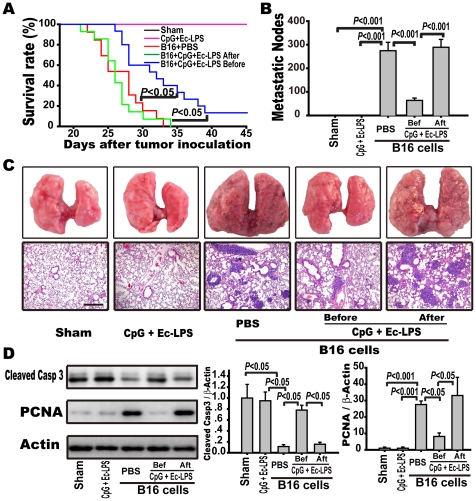
Prophylactic, but not therapeutic, administration of the complex attenuates pulmonary metastasis of B16 melanoma cells.C57BL/6 mice were injected i.v. with B16-F10 melanoma cells (5×105/mouse) and administered with the TLR4 agonist EC-LPS (12.5 µg/kg) plus the TLR9 agonist CpG ODN (0.25 mg/kg) i.p. every 3rd day for 3 doses before (prophylactic group) or after (therapeutic group) tumor cell inoculation. Control animals were treated with PBS or EC-LPS plus CpG ODN with an identical dosage and frequency as indicated in prophylactic group. The mice were humanely sacrificed, and their lungs were excised 14 days after tumor cell inoculation. Externally visible melanoma nodules on the lung surface were counted using stereo microscopy. (A) Kaplan-Meier graph representing the cumulative survival of mice in the indicated treatment groups. The data were analyzed using Kaplan-Meier survival analysis (n = 15 per group). (B) The metastatic nodules were counted and data presented as the mean ± S.E. (n = 15). (C) Data are representative lung samples (upper panel) and representative H&E staining of lung sections (below panel) (magnification: 100×). (D) The expression of cleaved caspase-3 and PCNA was detected by western blot (left panel) and corresponding quantification (right panel) in lung tissues 14 days after inoculation. Data are presented as the mean ± S.E. (n = 5 mice per group).